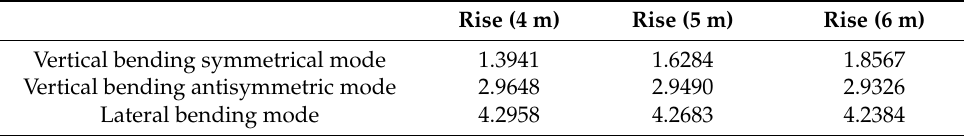
Table 3. Frequency calculation of the rise-to-span ratio